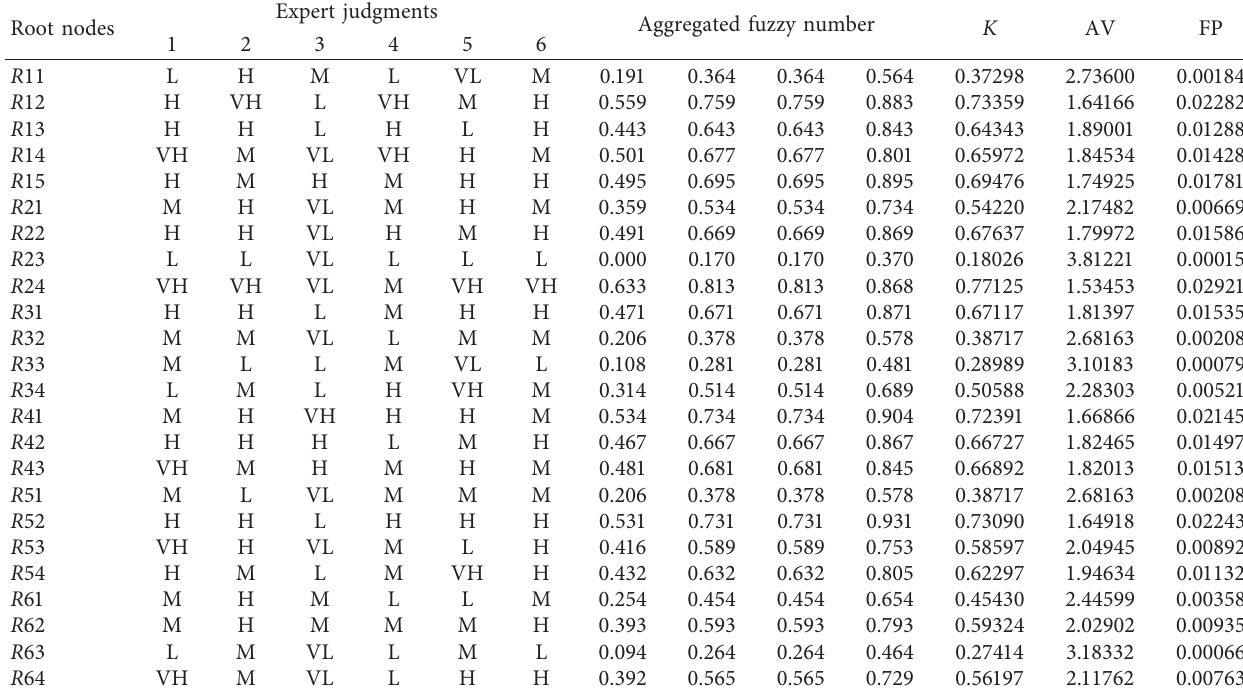
Table 6: Expert judgments for failures of root nodes in the forms of linguistic variables, corresponding aggregated fuzzy number, AV, and